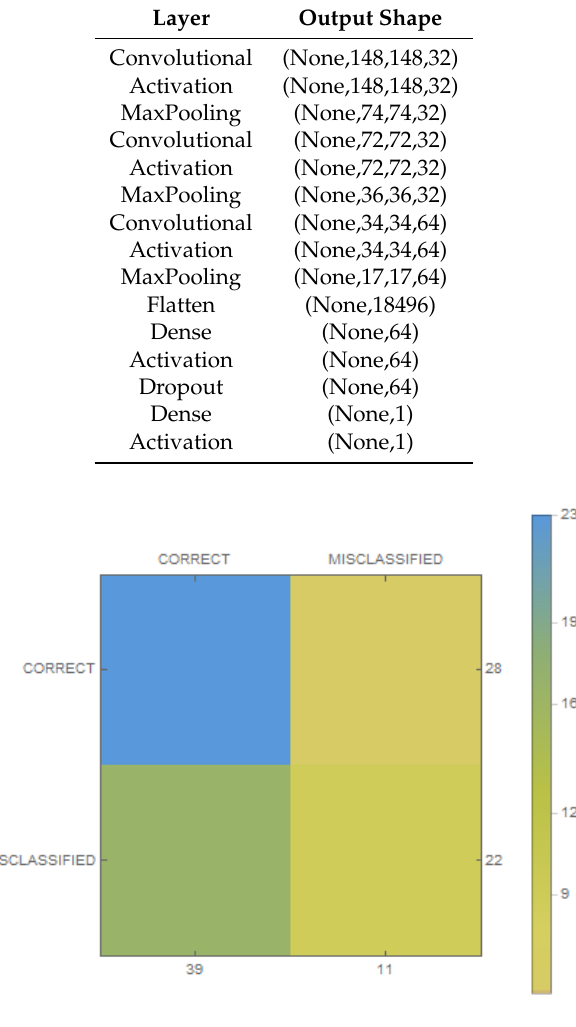
Figure 6. Confusion matrices for classic neural